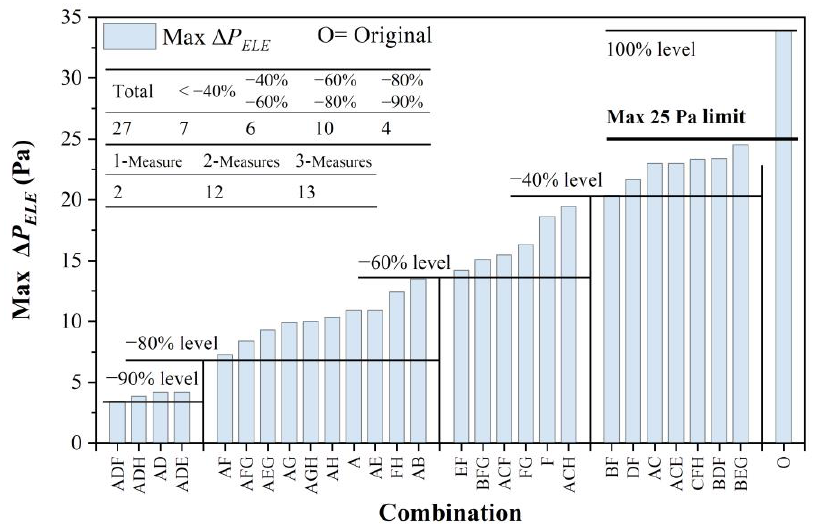
Figure 15. The candidate combinations for reducing maximum pressure difference at elevator doors. Table 2. The decision-making indexes of countermeasure combinations (top twenty). Top